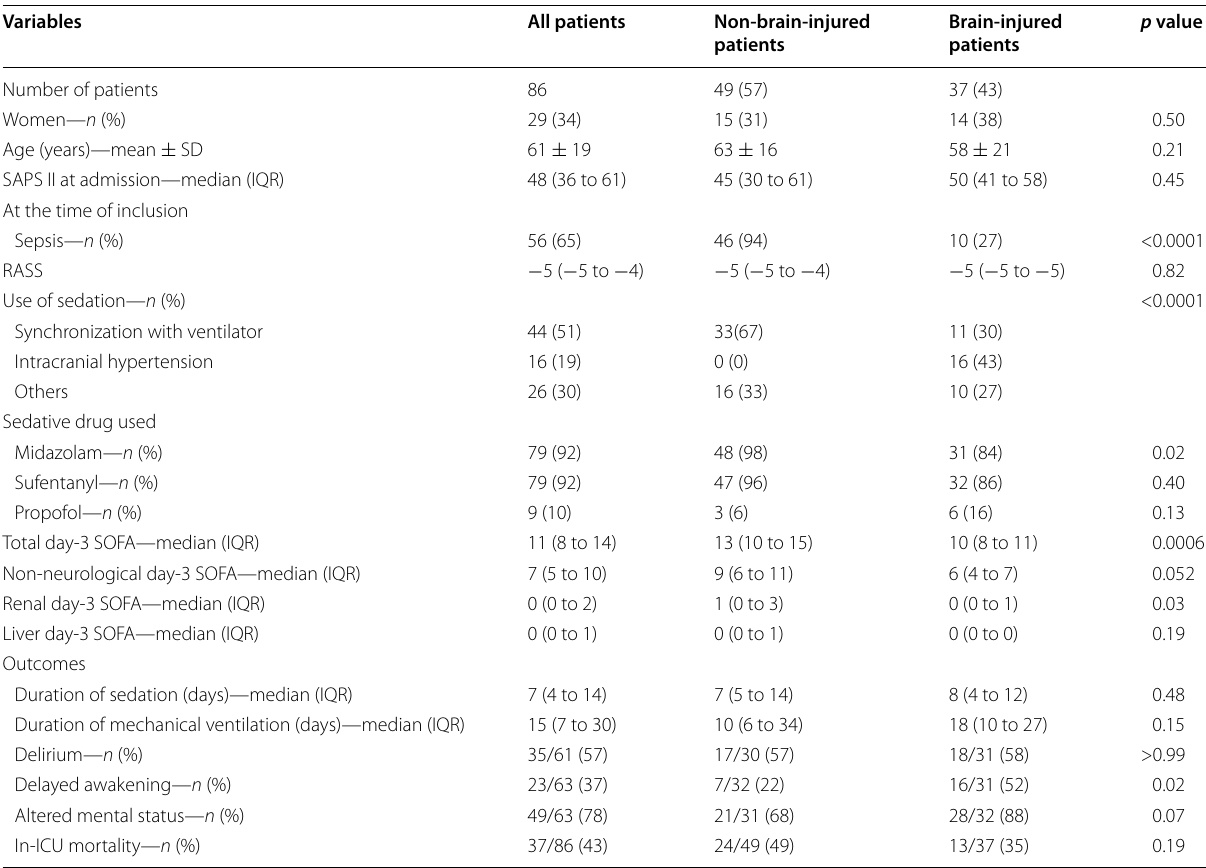
Table 2 Patients’ characteristics